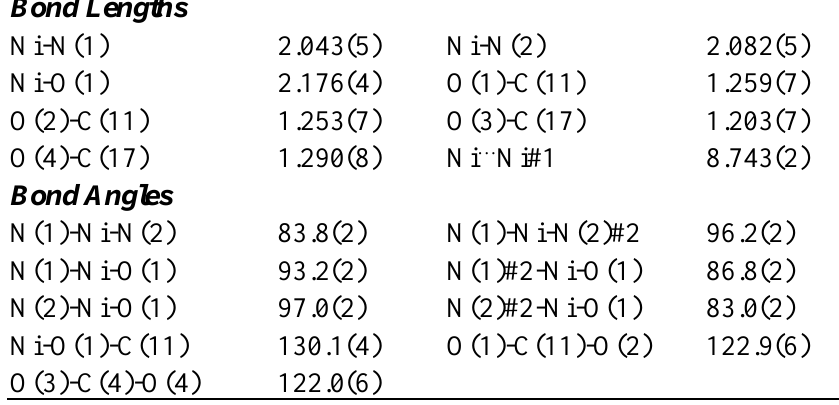
Table 1. Selected bond distances (Å) and angles (  ) for [Ni(L)(H-cpdc  )